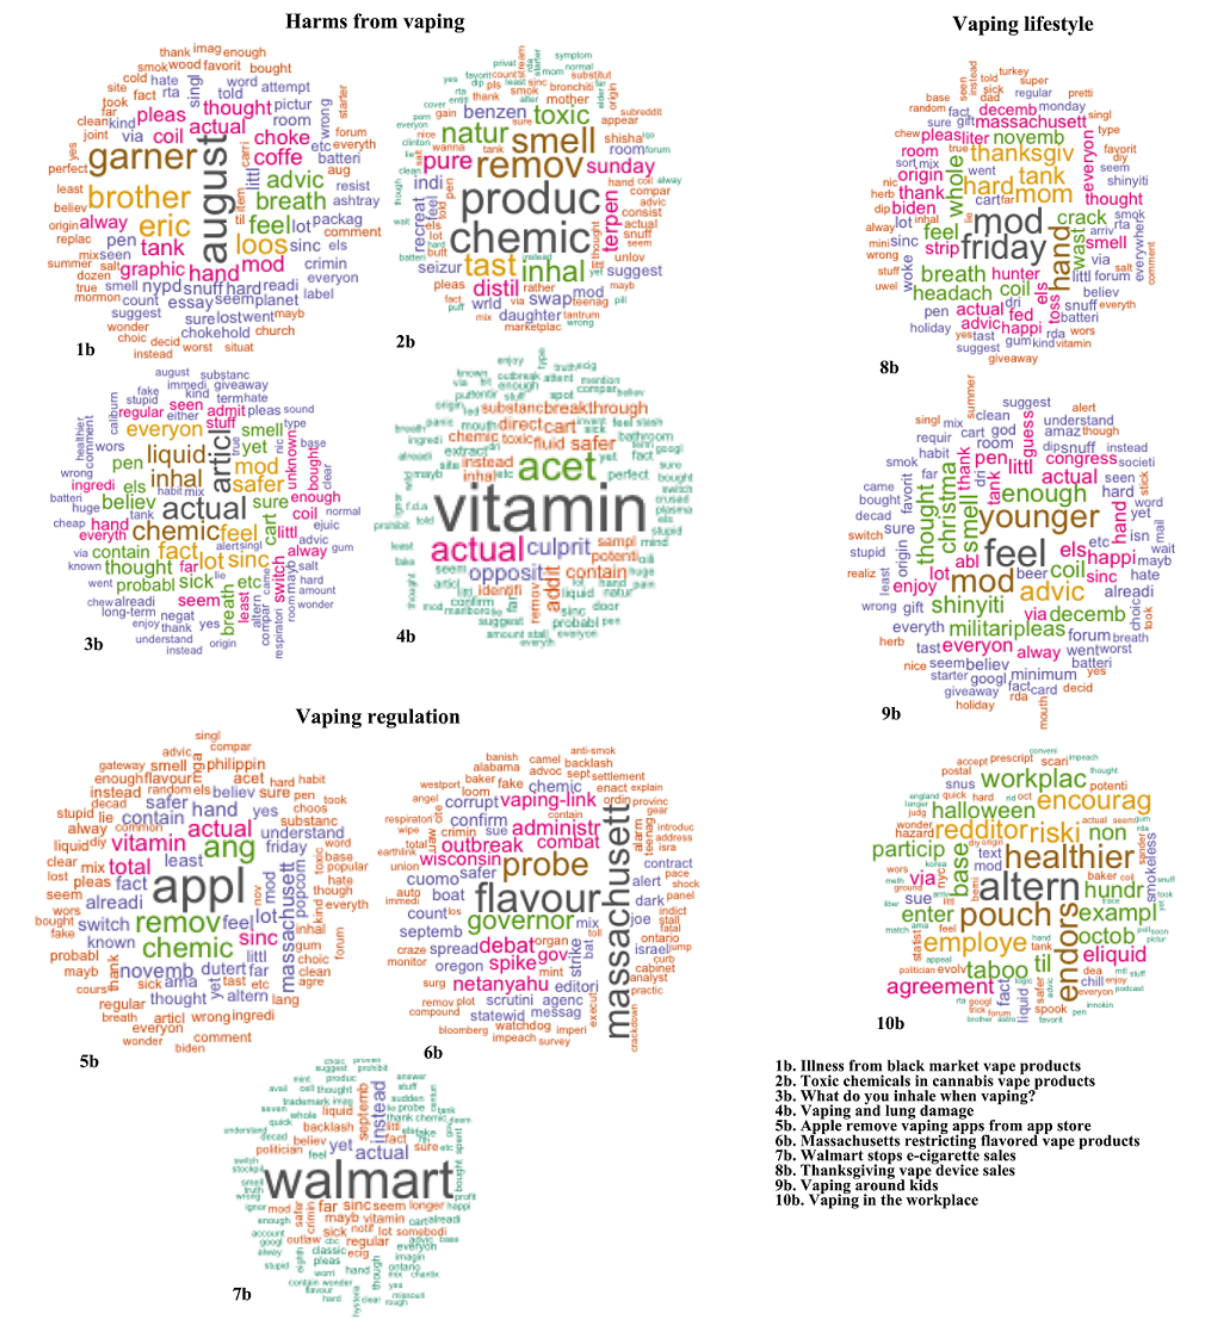
Figure 3. Major archetypes of vaping-related topics with example topics per archetype obtained by structural topic modeling before COVID-19 was reported to the WHO (August 1 to December 31, 2019). The word clouds are generated from the weights of the top 100 terms within a topic. Terms with larger weights are depicted in larger font sizes. Terms with approximately the same weight are depicted in the same